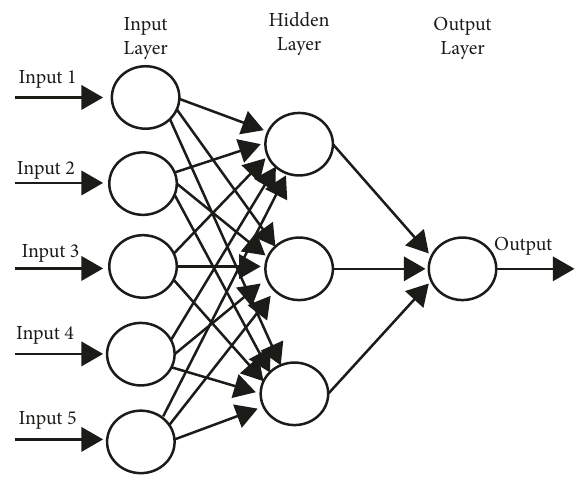
Figure 2: Diagram of neural